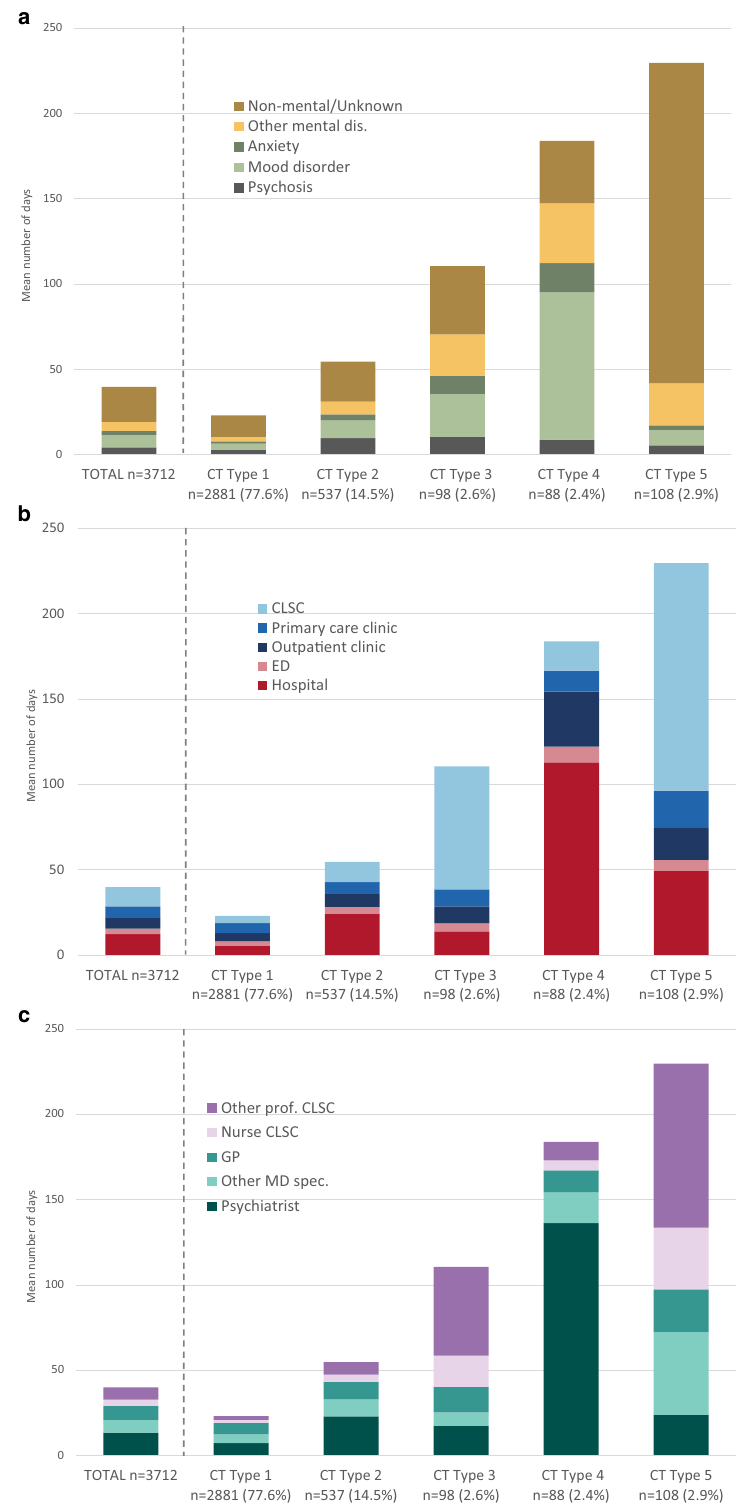
Fig. 3 Mean number of days of HCU according to the a reason for consultation, b care setting and c care provider 2 years before index groups, with a lower socioeconomic status and a high comorbid- emerged: Type 3 ( n = 98, 2.6%) can be described as moderate ity index (Table 2); Type 4 ( n = 88, 2.4%) can be described as high HCU for various mental disorders mainly in community services HCU mostly for mood disorders in hospitals and outpatient (CLSCs), with care delivered mostly by professionals and nurses clinics, with frequent psychiatrists ’ encounters (Figs. 2 and 3). (Figs. 2 and 3). Patients in Type 3 are mainly older women, living Patients in Type 4 are mostly middle-aged women, less deprived, in small towns or rural areas in a higher proportion than the other